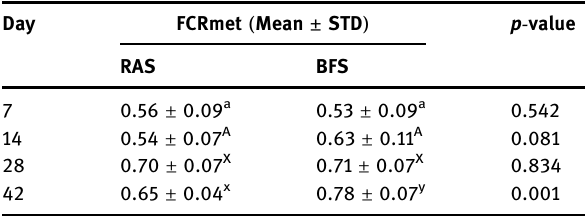
Di ff erent superscripts ( x, y ) indicate signi fi cant di ff erence